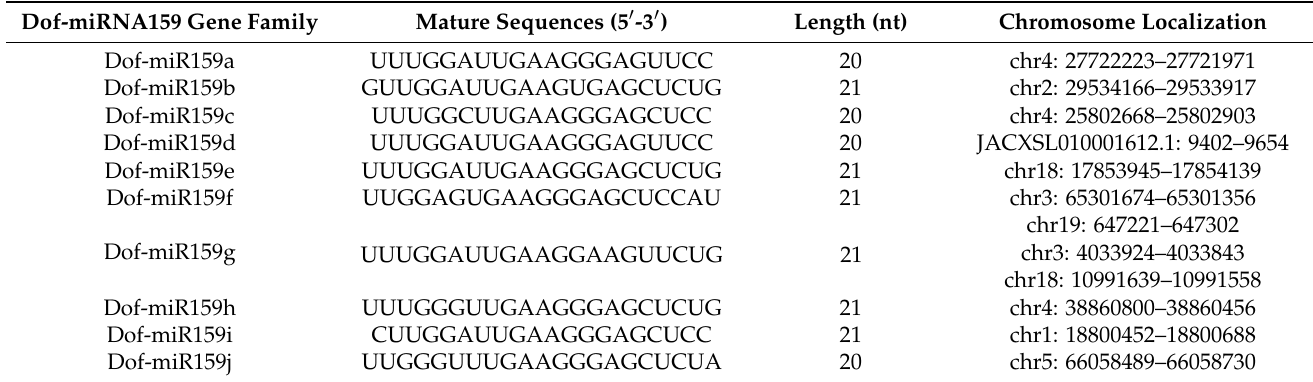
Table 1. Information on miR159 gene family in D. officinale . Mature Sequences (5 (cid:48) -3 (cid:48)